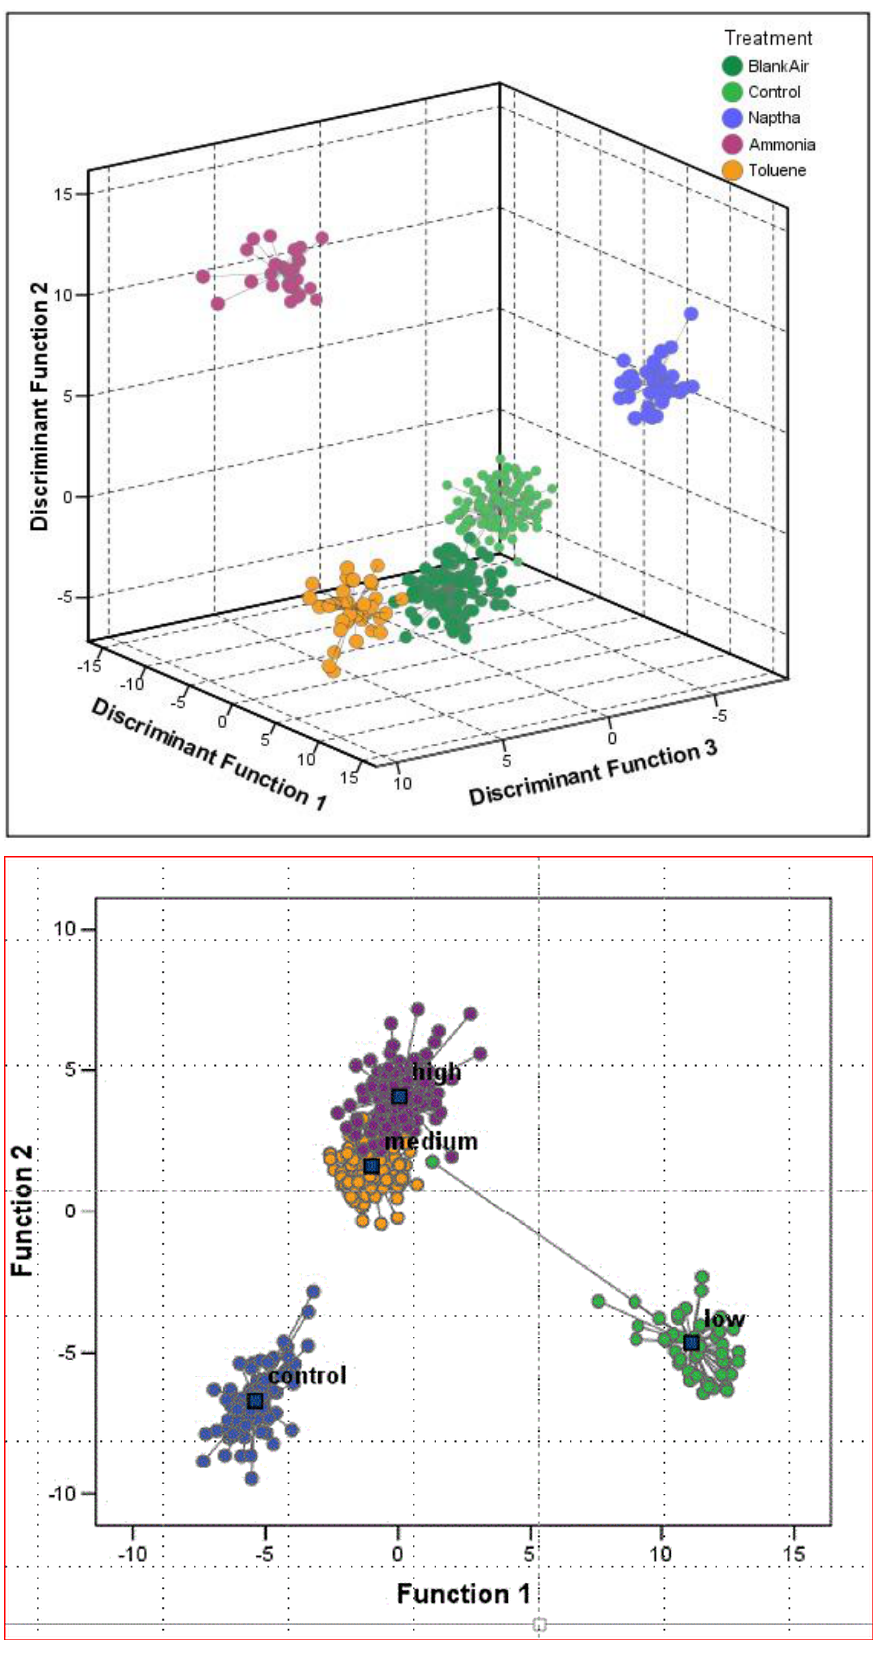
Figure 10. ( a ) Principal Component Analysis (PCA) of honey bee sonograms in response to exposure to a variety of chemicals, published in the patent disclosure [94]; ( b ) PCA of honey bee sonograms relative to infestation rates of varroa mites